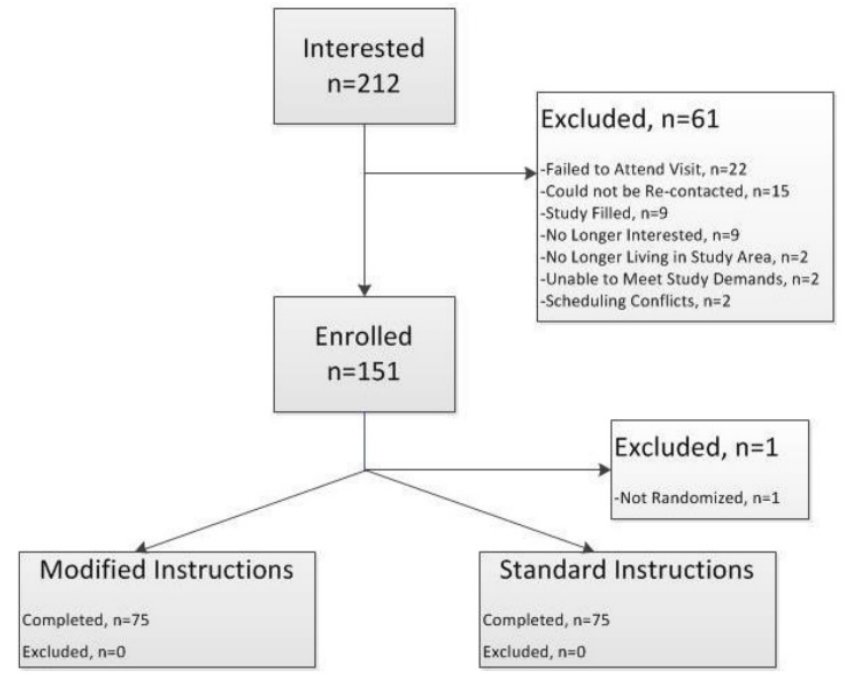
Figure 3. Randomized Control Trial Consort Diagram .